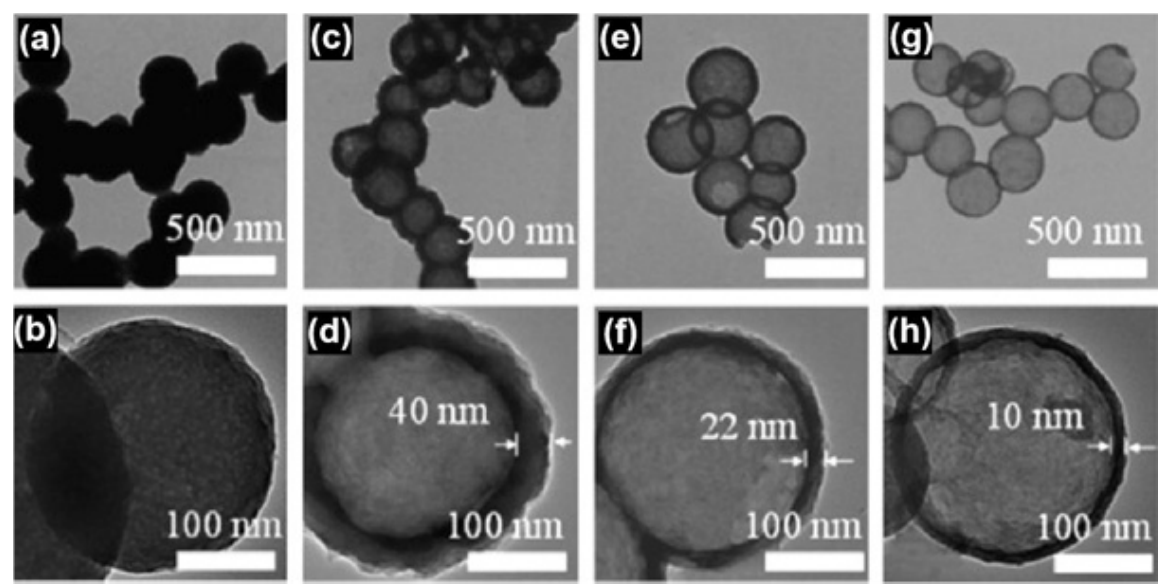
of 1:1 (a, b), 1:2 (c, d), 1:3 (e, f), and 1:4 (g, h), 4